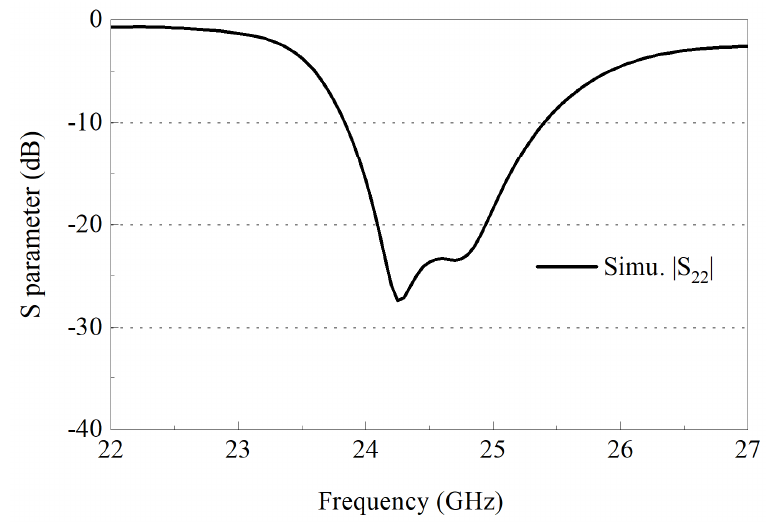
Figure 7. Simulated reflection coefficient of the dielectric rod antenna.